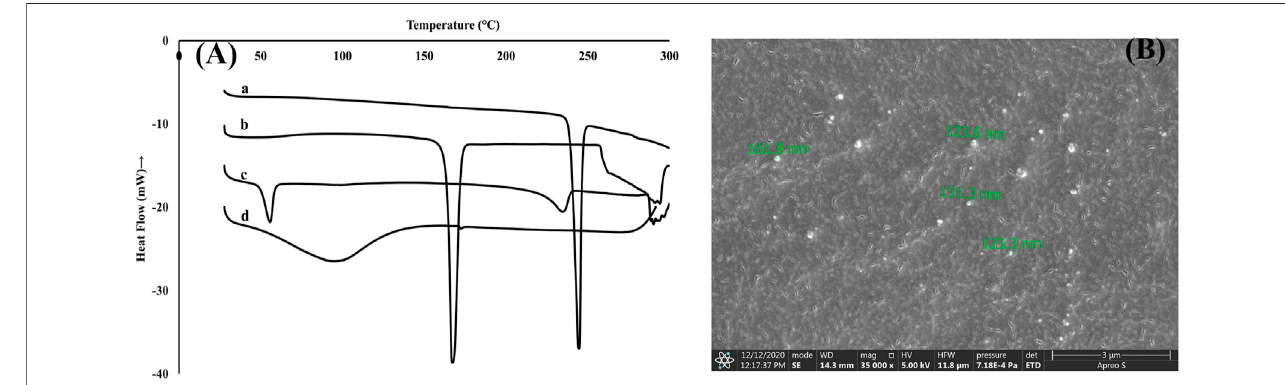
Frontiers in Pharmacology |